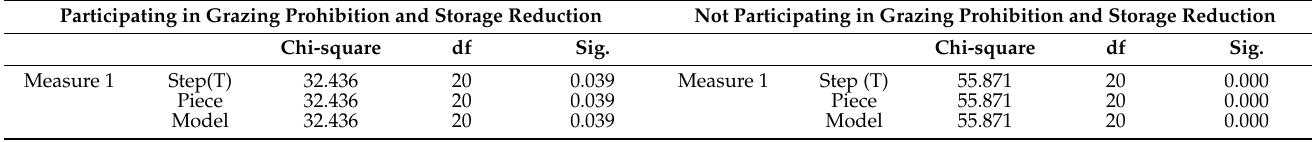
Table 8. Comprehensive test of the classification regression model coefficient.